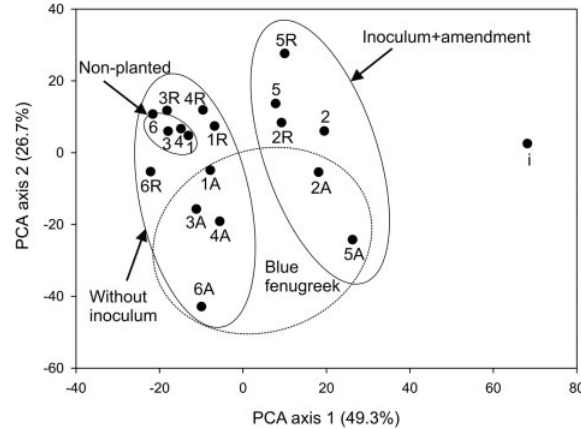
Fig. 3. Grouping of soil samples based on principal compo- nent analysis of DGGE fingerprints. Sample codes are given in Table 1. Circle with dashed line indicates soil samples with blue fenugreek cultivation. Abbreviations: i (cid:2) inoculum